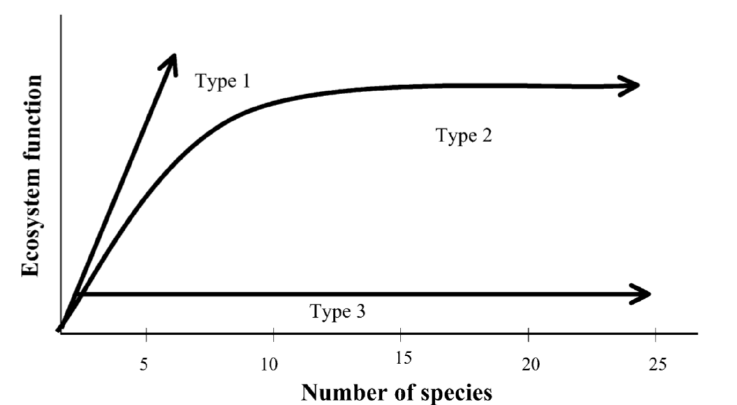
Figure 1. Possible relationships between biological diversity and ecosystem functions. Type 2 curve has been suggested to be the most accurate pattern (reproduced from